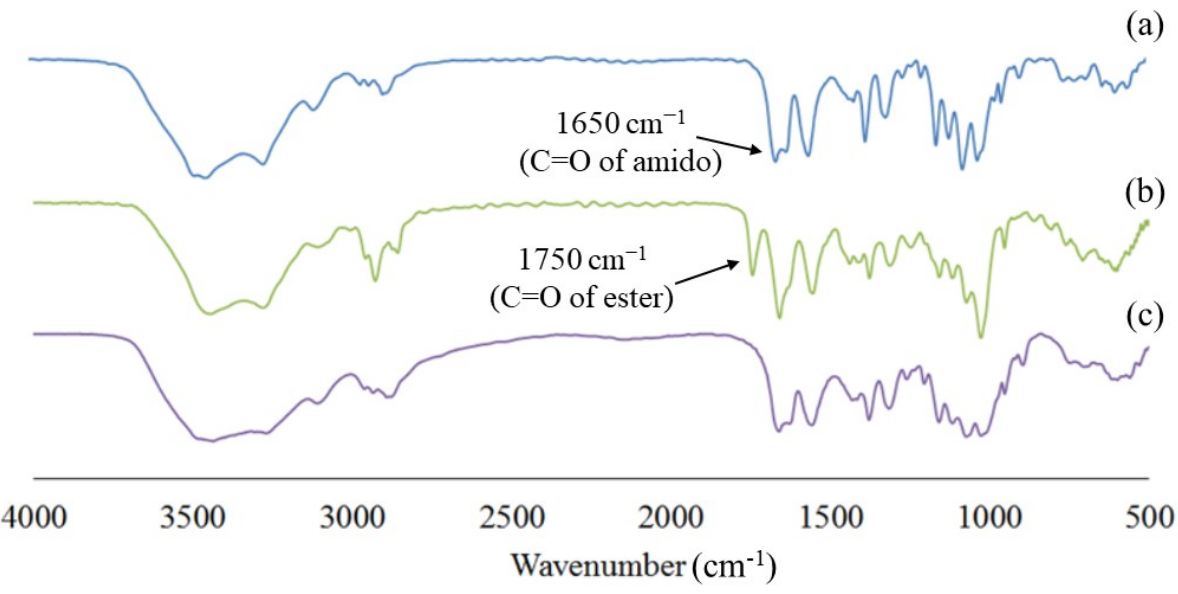
Figure 5. IR spectra of ( a ) chitin powder, ( b ) ChNFs with oligochitin dihexanoate graft chains, and ( c ) ChNF film with oligochitin graft chains.